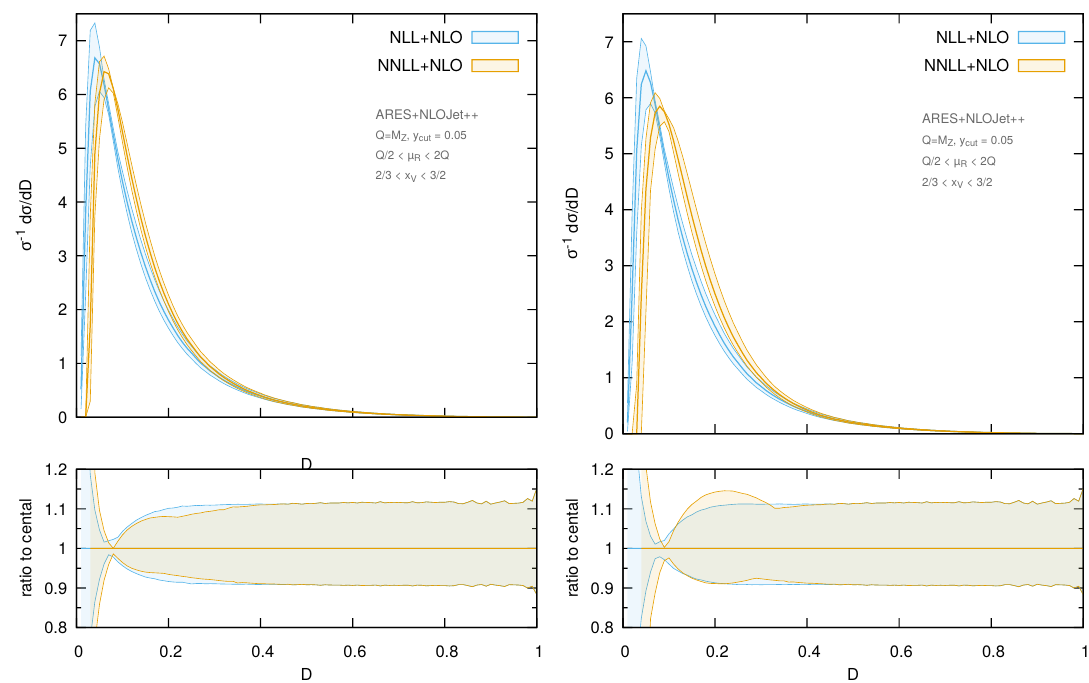
Figure 5 . The matched distribution for y cut = 0 : 05 and Q = M Z . The left plot using the X const scheme and the right using the X prod scheme.